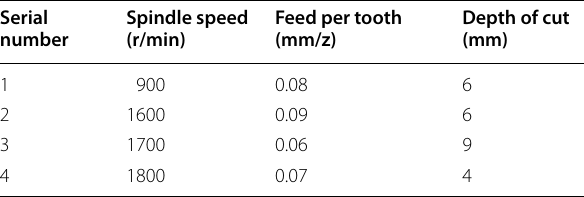
Table 1 Experiment parameters for verification of surface roughness empirical